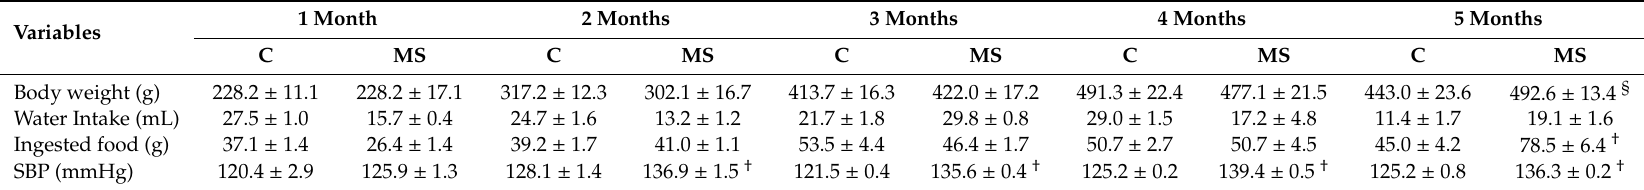
Table 1. General characteristic in experimental groups.